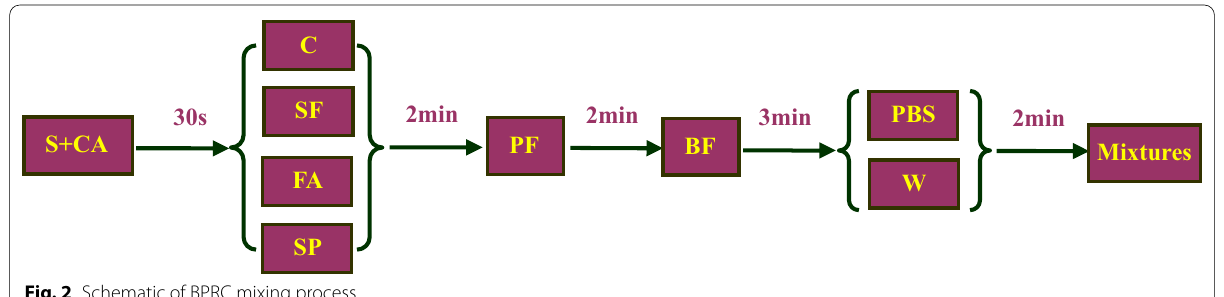
Fig. 2 Schematic of BPRC mixing